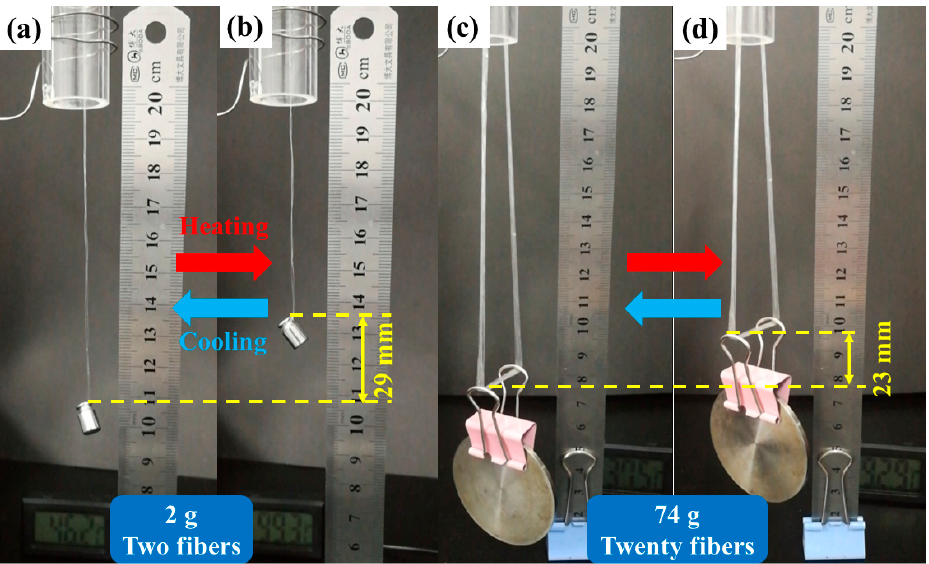
Figure 10. The reversible actuation capability was increased by combing multiple fibers.